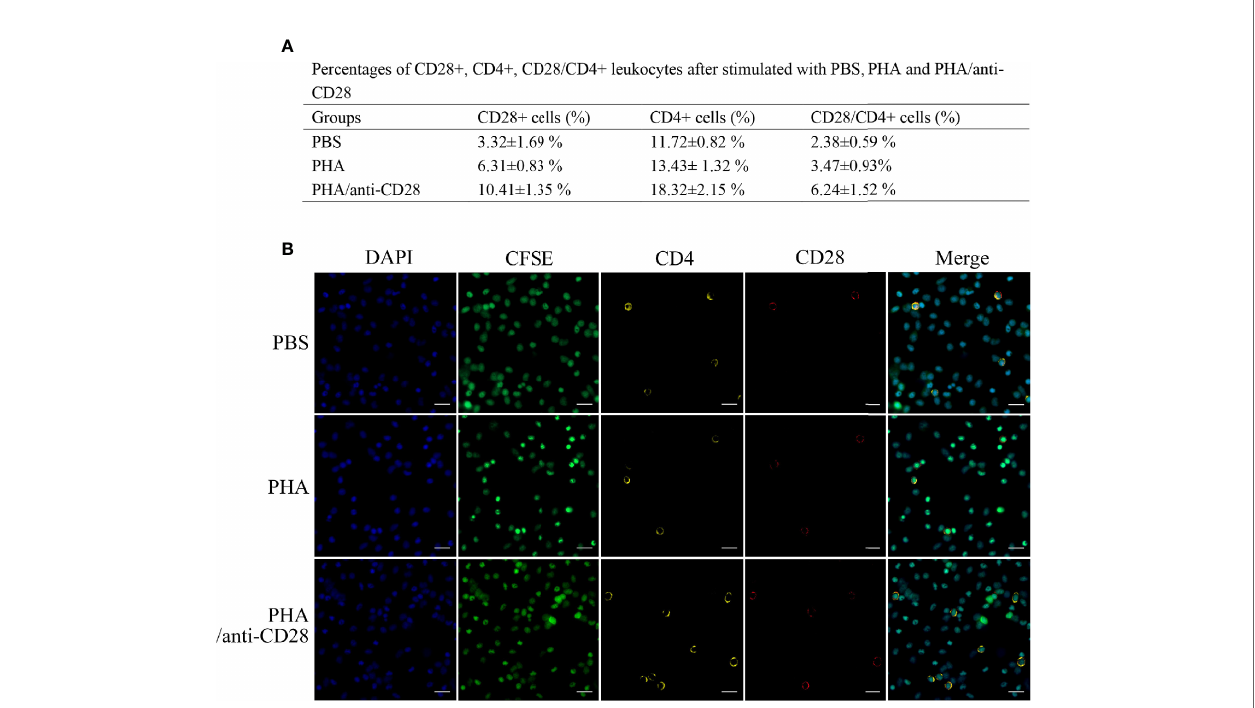
FIGURE 8 | (A) The percentage of CD28+, CD4+, and CD28+/CD4+ PBLs after stimulation with PBS, PHA, and PHA/anti-CD28, respectively. (B) Co-localization of CD28+/ CD4+ double-positive PBLs after stimulation with PBS, PHA, and PHA/anti-CD28, respectively. Indirect immuno fl uorescence detection of CFSE and CD28+/CD4+ cells of cultured PBLs after 72 h; data are representative of nine individuals; bar = 10 m m. The cell nuclei were counterstained in blue with DAPI. The unimmunized serum was used as the primary antibody for negative control (data not